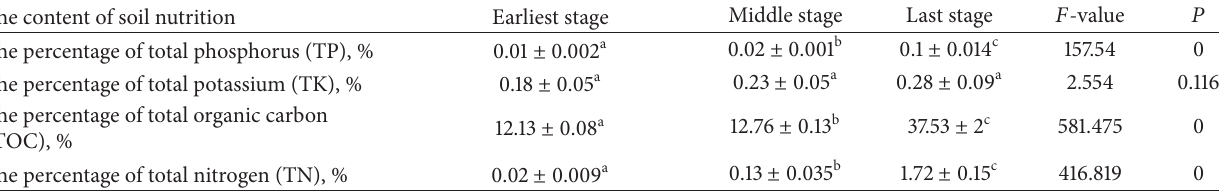
Table 5: Kruskal-Wallis ( 𝐻 ) test of soil nutrients during three succession stages in the foreland of Glacier-BS1, Mt. Yulong. The content of soil nutrition Earliest stage Middle stage Last stage 𝐹 -value 𝑃 The percentage of total phosphorus (TP), % The percentage of total potassium (TK), % The percentage of total organic carbon (TOC), % The percentage of total nitrogen (TN),